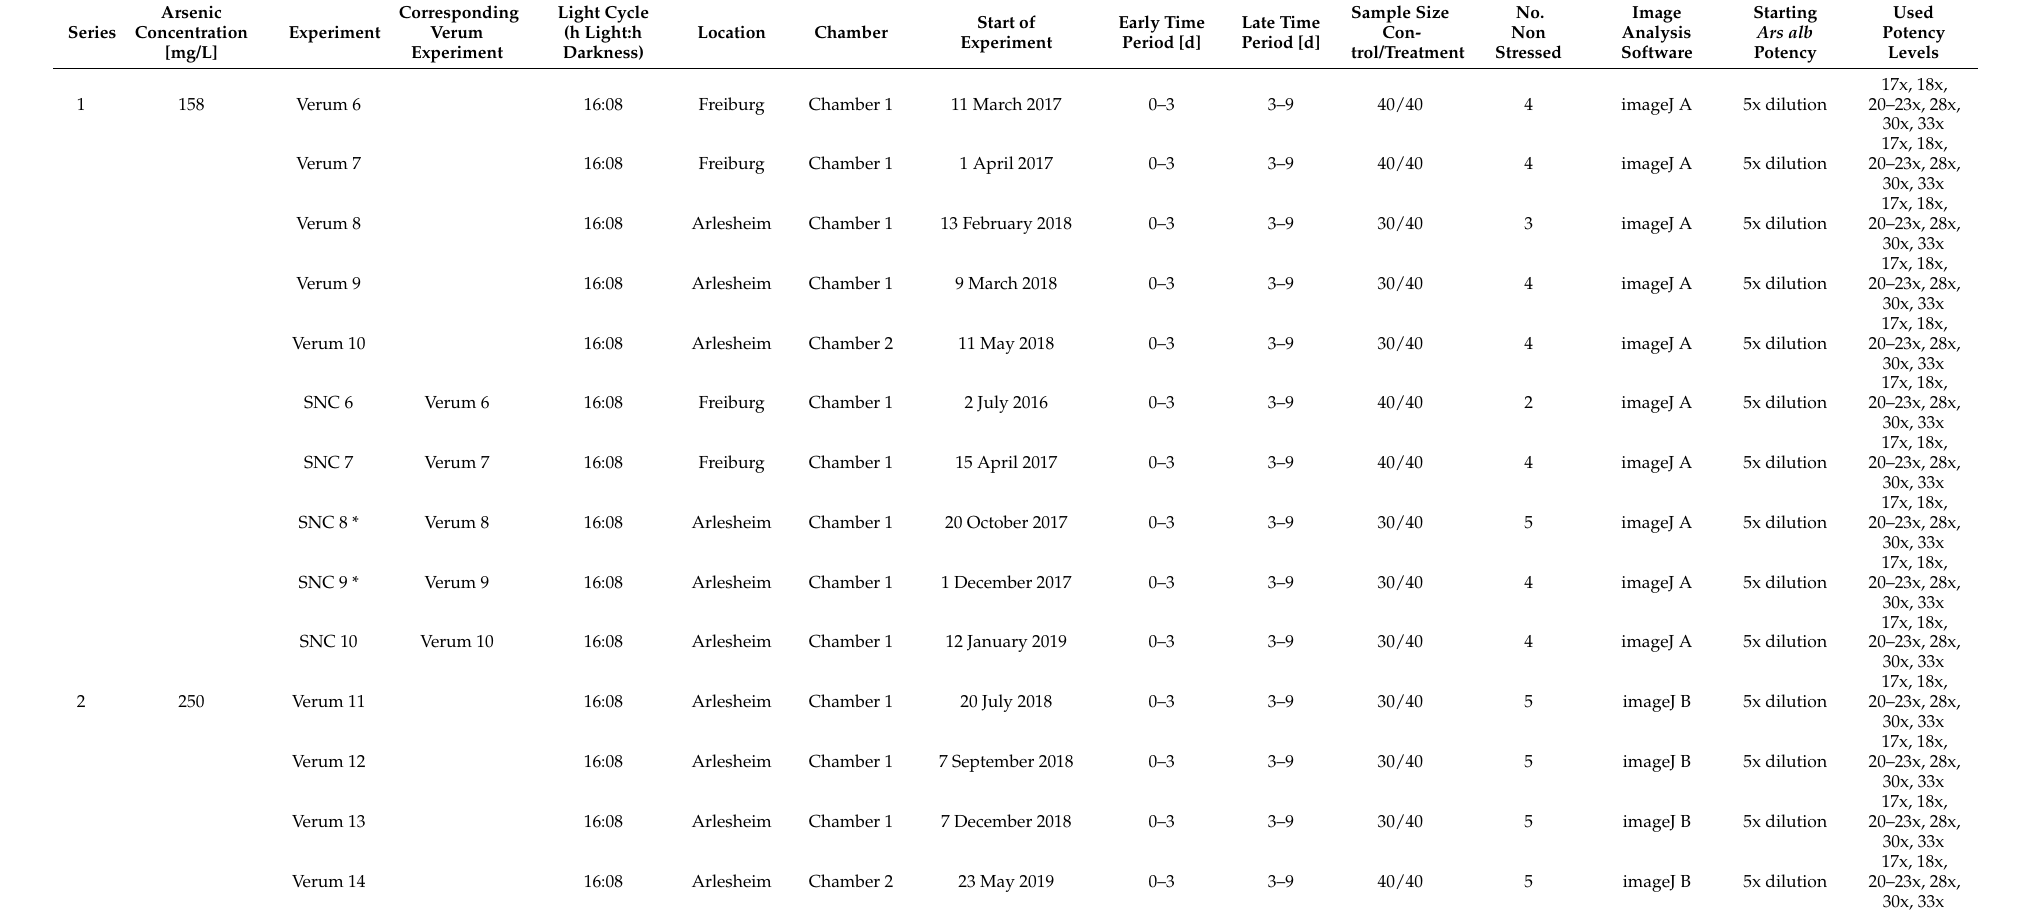
Table 1. Overview of experimental series concerning location, time and general setting of single experiments; * 10 data points were removed from SNC for alignment according to verum experiments. Sample size refers to the number of beakers with Lemna gibba L. No. non-stressed = number of beakers with Lemna gibba L. that were not pre-treated with 158 or 250 mg/mL AsNa 2 HO 4 . Chamber 0: see (Jäger et al. 2010 [13]); chamber 1 and 2: see Figure 1; differences between ImageJ analysis software “imageJ A” and “imageJ B” see Section 4.3.2 and Supplement